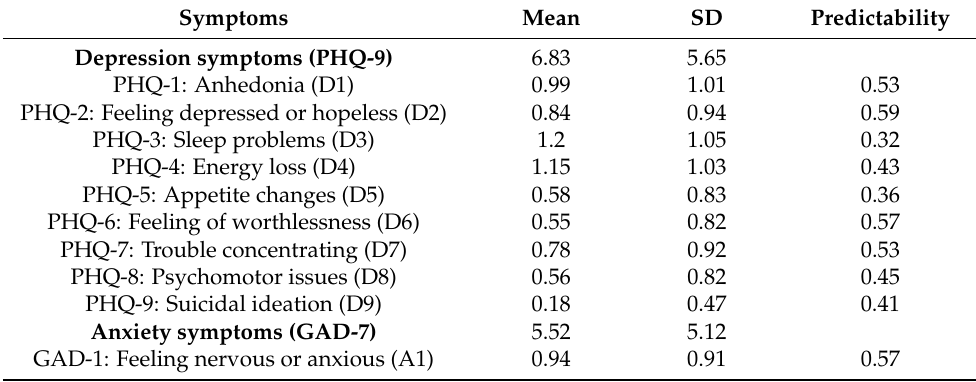
Table 2. Mean scores, standard deviations, and predictability for each symptom of the PHQ-9 and